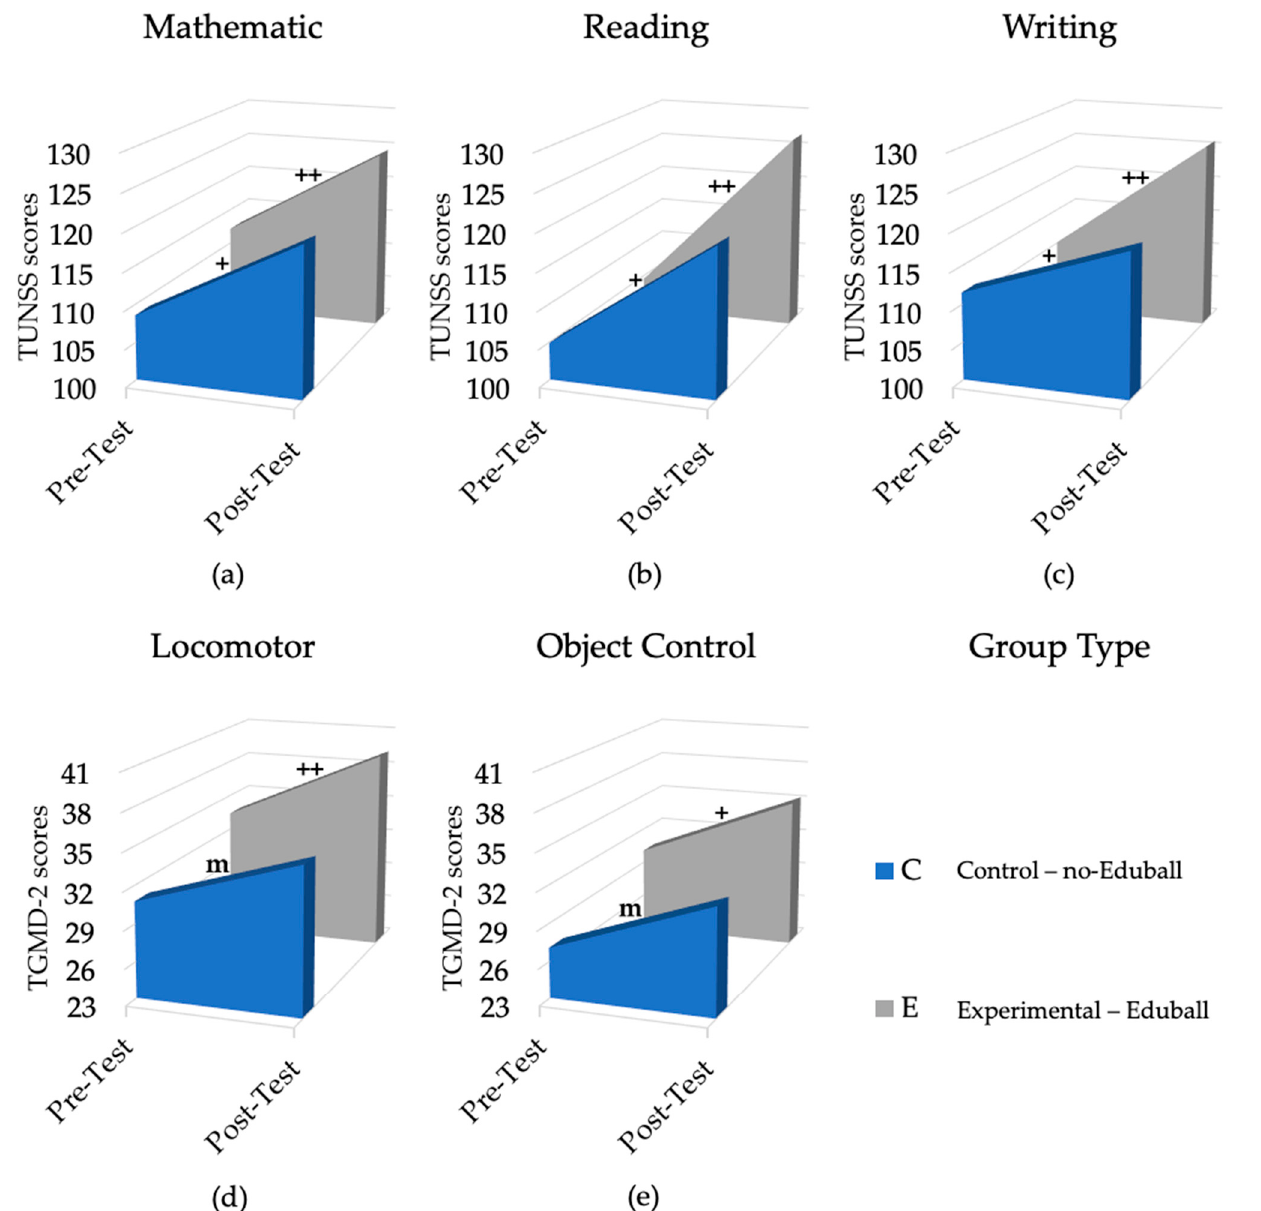
Figure 4. Results of the experiment (pre-test vs. post-test), in terms of cognitive and motor skills, divided into two groups (no-Eduball vs. Eduball). ( a ) The results of the two groups in terms of mathematical skills; ( b ) the results of the two groups in terms of reading skills; ( c ) the results of the two groups in terms of writing skills; ( d ) the results of the two groups in terms of total locomotor skills; ( e ) the results of the two groups in terms of total object control skills. Plus (+) symbols reflect effect size: + large effect, ++ very large effect (m—medium effect).